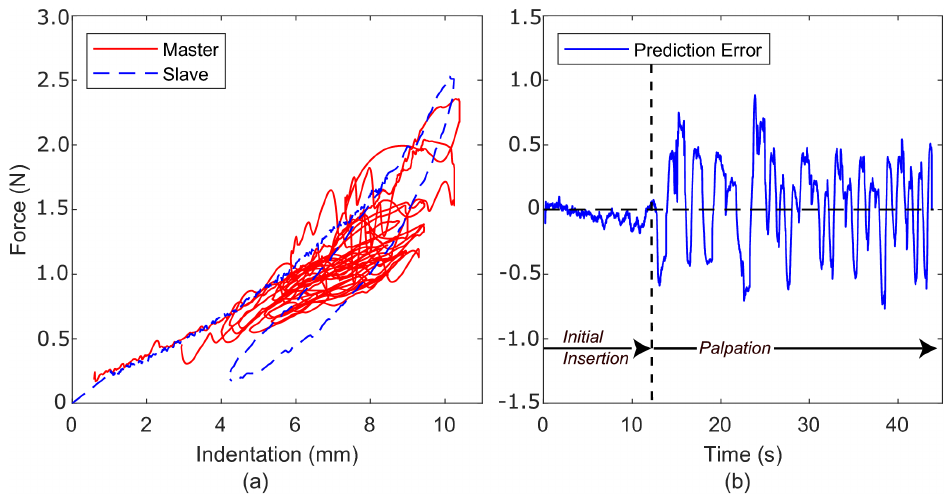
Figure 10. ( a ) Force-indentation profile using the Kelvin–Voigt force model as the virtual environment. Note that only the slave force outer envelope is presented for clarity. ( b ) The master prediction error.